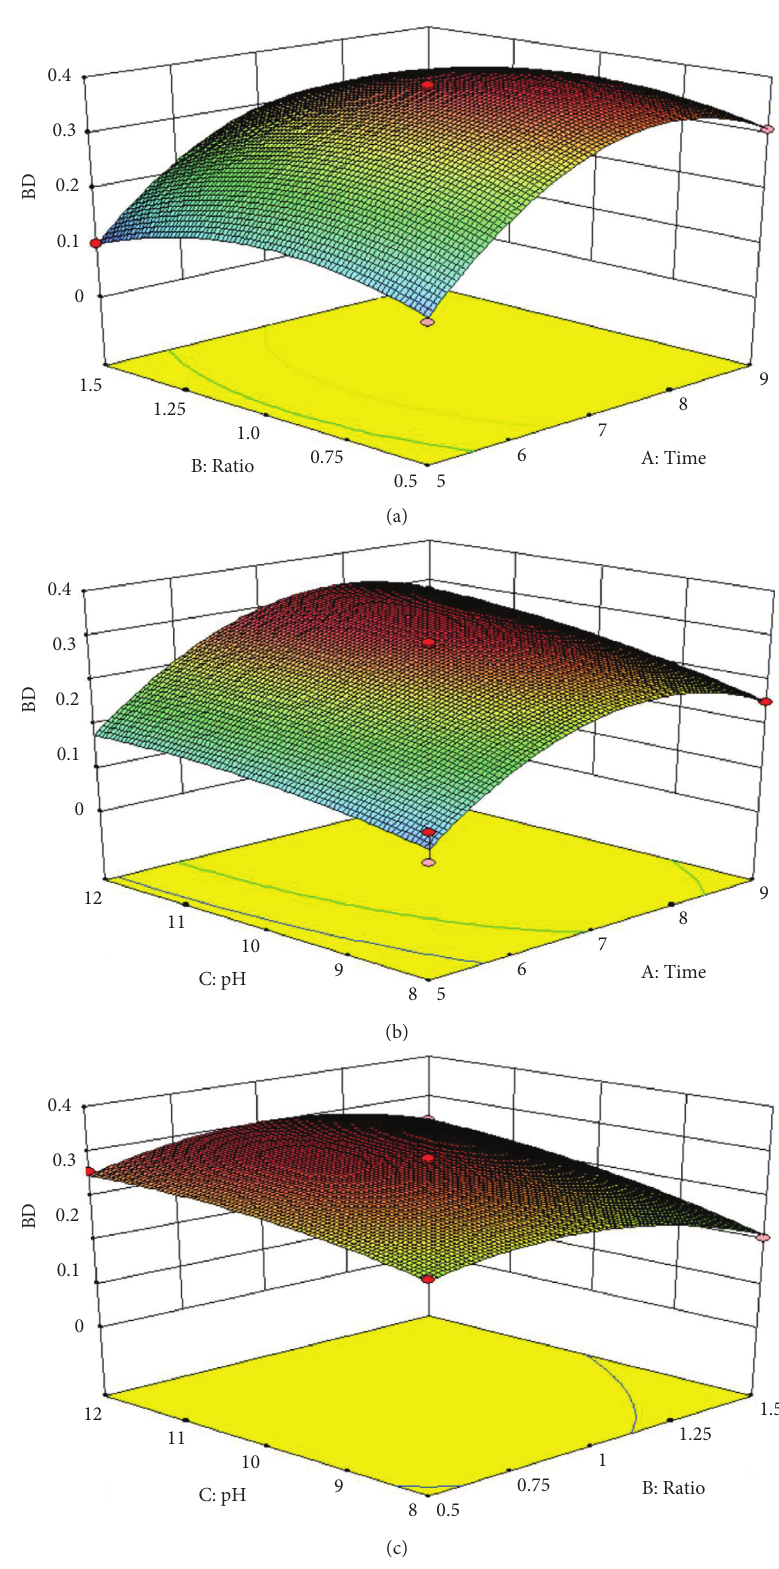
Figure 1: Three-dimensional figures of interactive effects of heating time (time), volume ratio of propylene glycol to ddH (pH) on browning degree (BD) of an L-arabinose/glycine Maillard reaction